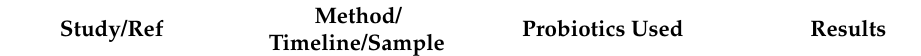
Table 3. Colorectal cancer, diabetes mellitus comorbidity, and probiotics (clinical